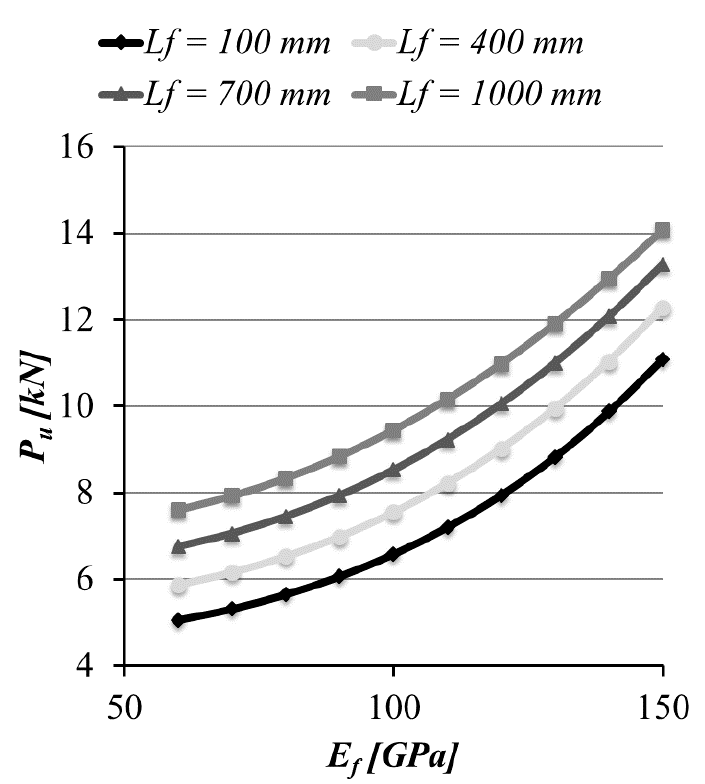
Figure 9. Influence of the Young’s modulus of the FRP and the active bond length on the debonding force.